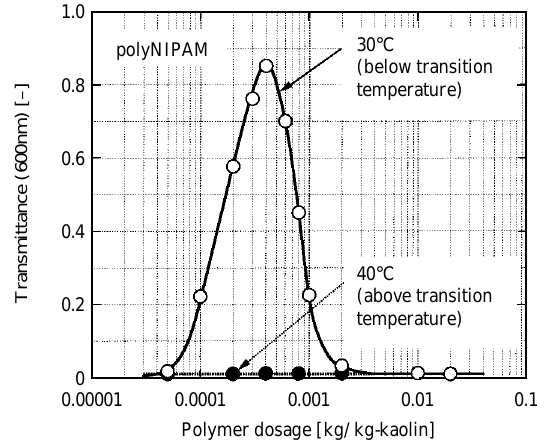
flocculant: The transmittance of the supernatant in- creased with increasing the polymer dosage, and then decreased after peaking. This means there is an opti- mum polymer dosage. At and near that dosage, the bridging adsorption of polyNIPAM on the suspended kaolin particles encourages floc formation, and the transmittance of supernatant increases. But when too much polyNIPAM is added, the surfaces of the sus- pended kaolin particles are covered with polyNIPAM, and thereby disperse stably, which reduces transmit- tance (Sakohara et al., 1980). At 40°C, however, flocs were hardly formed no matter what the additive amount of polymer, and the supernatant transmittance remained low. It is considered due to the fact that the added polyNIPAM molecules immediately became hydrophobic and that they could not adsorbed onto the kaolin. As a result, flocs did not form. Therefore, to make kaolin adsorb the polyNIPAM as in the Fig. 1 model, the operation must be performed be- low the transition temperature.